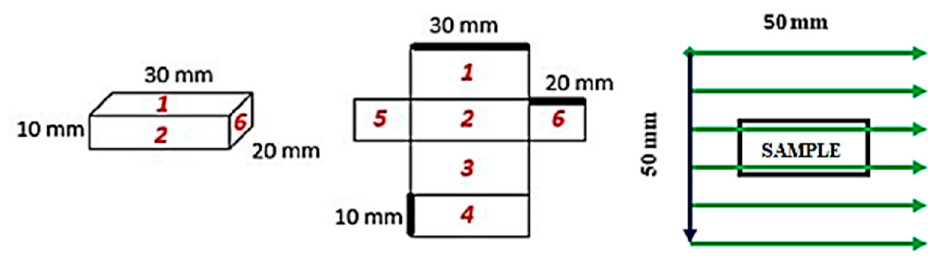
Figure 5. Biomaterial specimen dimensions, numbering, and distribution of scanning points for heat treatment measurements.